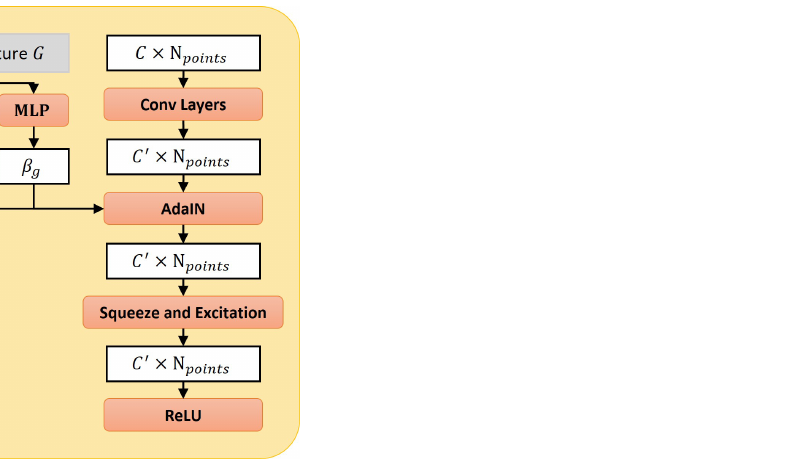
Figure 9. Style-based module with AdaIN (Adaptive Instance Normalization